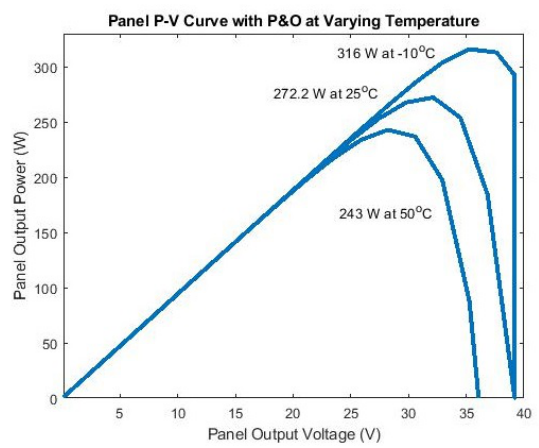
Figure 3. P-V characteristic under changing irradiation.